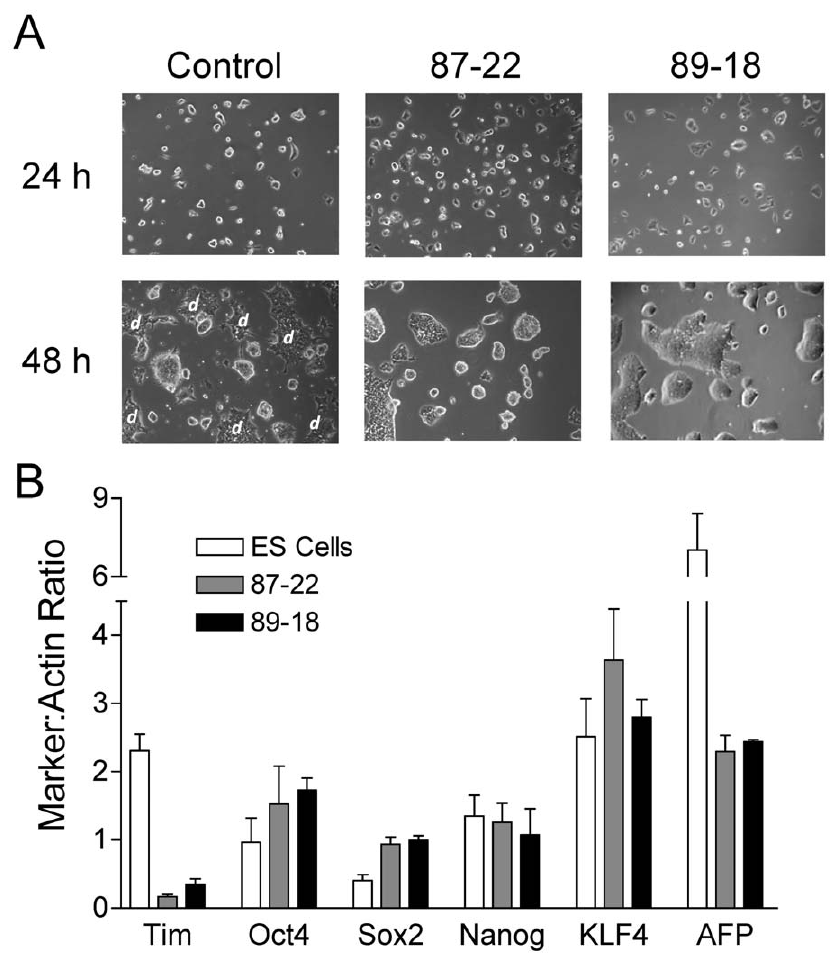
Figure 4. Knockdown of Tim suppresses spontaneous differentiation of mES cells. A , Representative images of control and Tim knockdown ES cell lines 87-22 and 89-18 after 24 and 48 h in culture. Note that spontaneously differentiating mES cell clusters are readily apparent in control ES cell cultures by 48 h (flat colonies with ragged edges; ‘‘ d ’’) but are absent from the Tim knockdown cultures. B , Analysis of self-renewal and differentiation marker expression in Tim knockdown cell lines. Expression levels of the self-renewal markers Oct4, Sox2, Nanog, KLF4, the differentiation marker AFP, as well as Tim were assessed by quantitative immunoblotting (LI-COR Odyssey infrared imaging system) of cell lysates from parental ES cells as well as the Tim knockdown ES cell lines 87-22 and 89-18. Actin immunoblots served as loading control. Immunoblots were performed in triplicate and the level of each protein was normalized to actin and is shown in the bargraph as the mean 6 S.E.M. Sox2 expression levels were significantly increased in the Tim knockdown cells relative to parental ES cells (p , 0.05), while AFP showed a statistically significant decrease (p , 0.05). While small increases in Oct4 expression were also observed in the Tim knockdown cell lines, these changes were not statistically